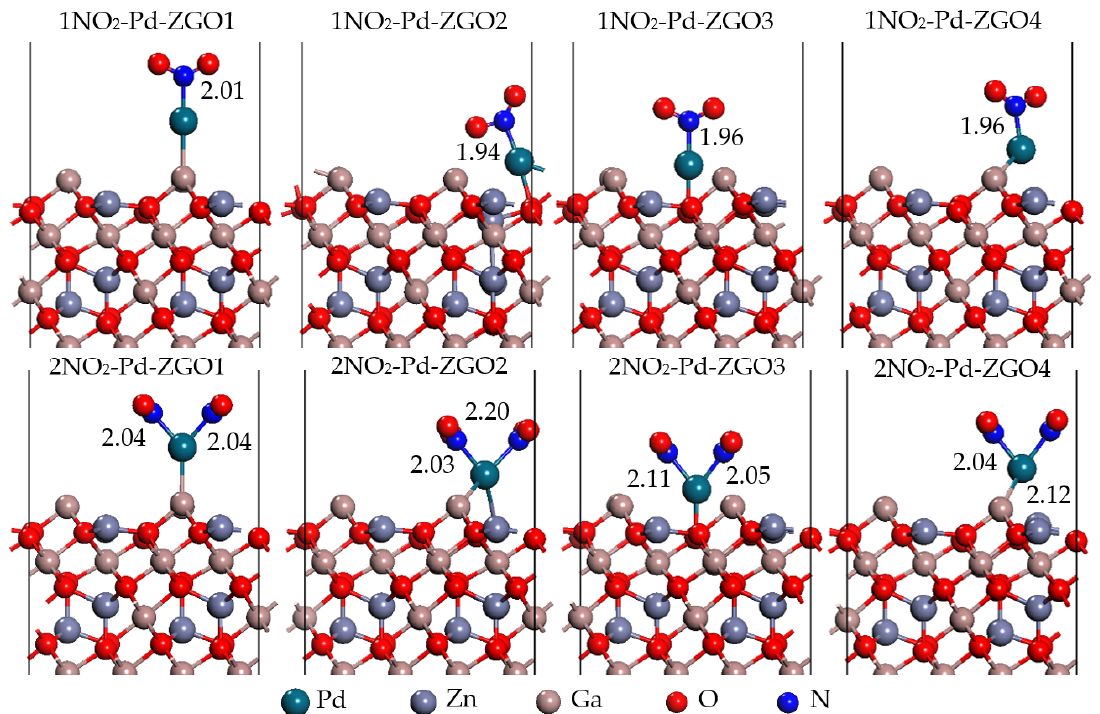
Figure 3. Side view of the n NO 2 molecules on Pd-ZnGaO i surface. The equilibrium bond lengths of n NO 2 -Pd-ZGO i are listed in Table 1.